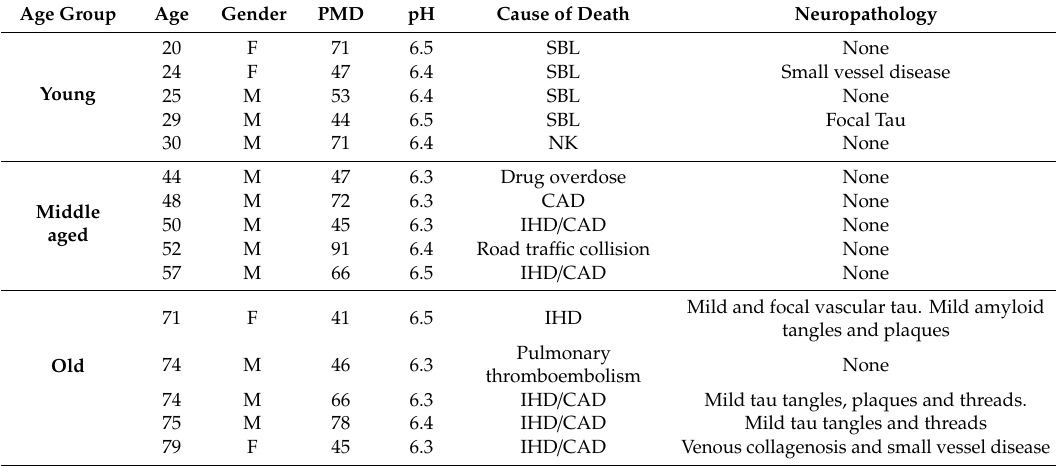
Table 3. Demographics of human cases used in gene expression analysis: age, gender, post-mortem delay, brain pH, cause of death and